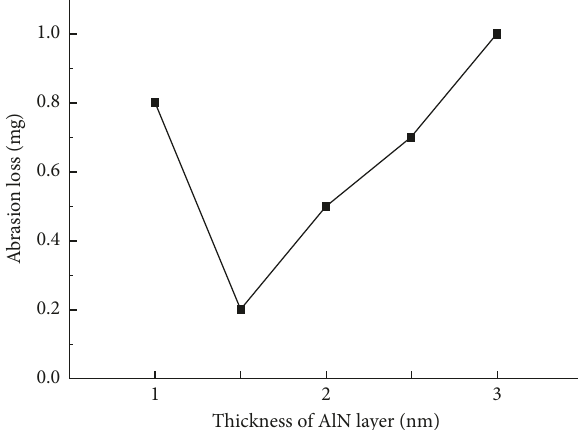
Figure 6: Abrasion loss of TiSiN/AlN nanomultilayers with different thicknesses of AlN